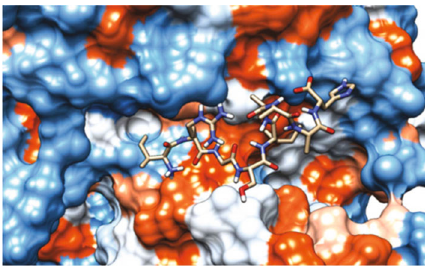
Figure 21: Illustration of the 3D interaction of the best docking poses of IRGSIAAAH in the binding sites of HLA-DRB1 ∗